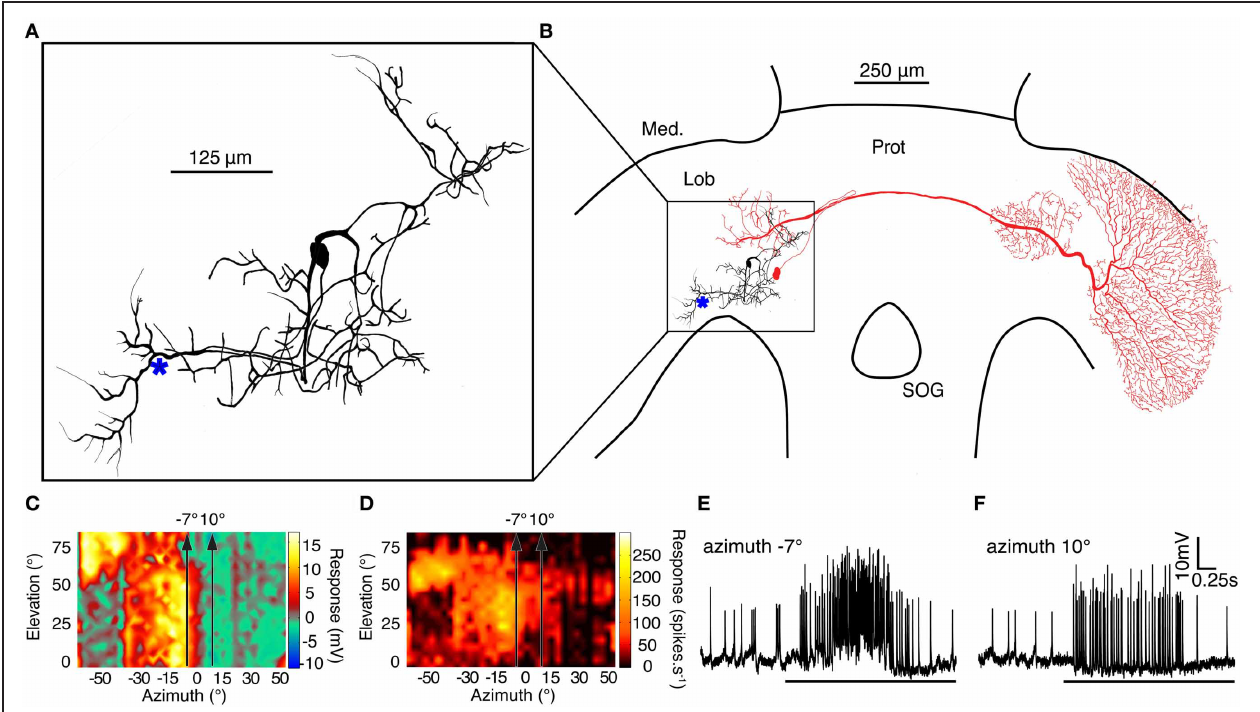
FIGURE 7 | (A) A Lucifer Yellow CH fill of the compact mid-brain small target motion detector neuron, BSTMD1. ( ∗ indicates approximate recording site) (B) BSTMD1 (black) in context of the dragonfly brain showing a likely input arborisation in the proximal lobula and a second region of inputs/outputs in the lateral midbrain. CSTMD1s (red) inputs are in a similar region of the lateral midbrain. (C) The graded (generator potential) receptive field of BSTMD1 mapped by upward motion of a